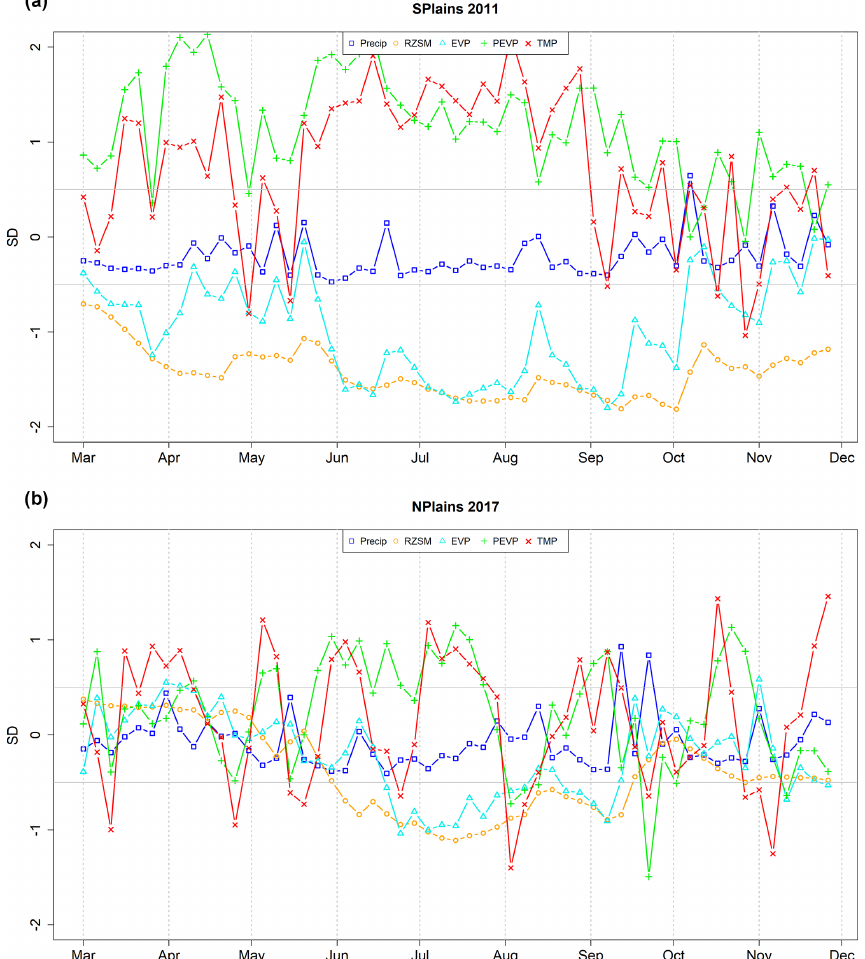
Figure 7. Time series of standardized main climate variables formulating the different flash drought definitions averaged within regions of observed flash drought events. (a) 2011 flash drought observed over Southern Plains. (b) 2017 Northern Plains flash drought event. Gray horizontal lines represent ± 0 . 5 standard deviation, which is roughly equivalent to the 30th percentile of each variable’s